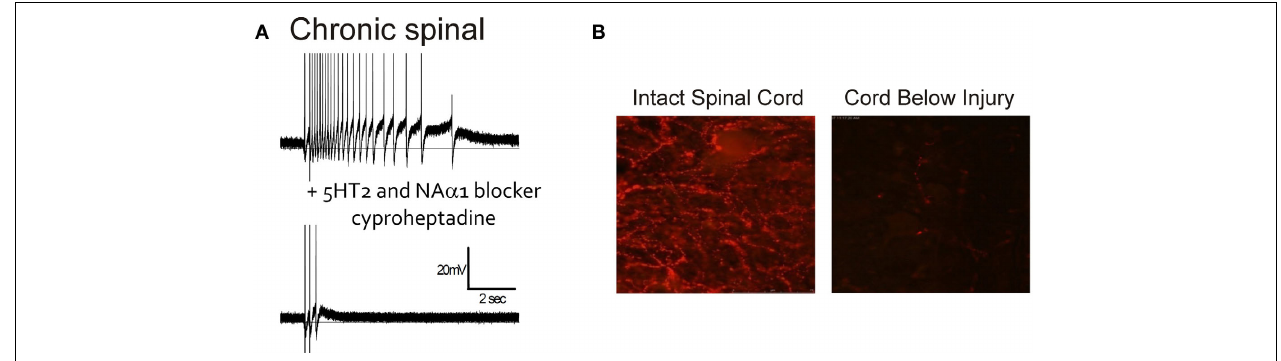
FIGURE 4 | Endogenous activation of 5HT2/NA α 1 receptors with little monoamines below injury. (A) Top trace : Intracellular recording from motoneuron of chronic spinal rat. Single-pulse, dorsal root stimulation evokes long-lasting plateau potential and self-sustained firing. Bottom trace : Blocking of 5-HT 2 and NA α 1 receptors with cyproheptadine eliminates PIC-mediated